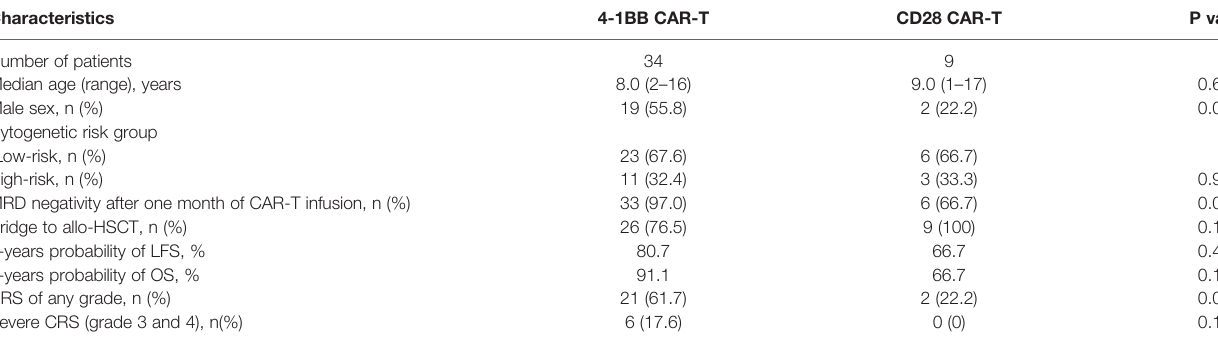
TABLE 4 | Characteristics of patients strati fi ed by 4-1 BB CAR-T and CD28 CAR-T. Characteristics Number of